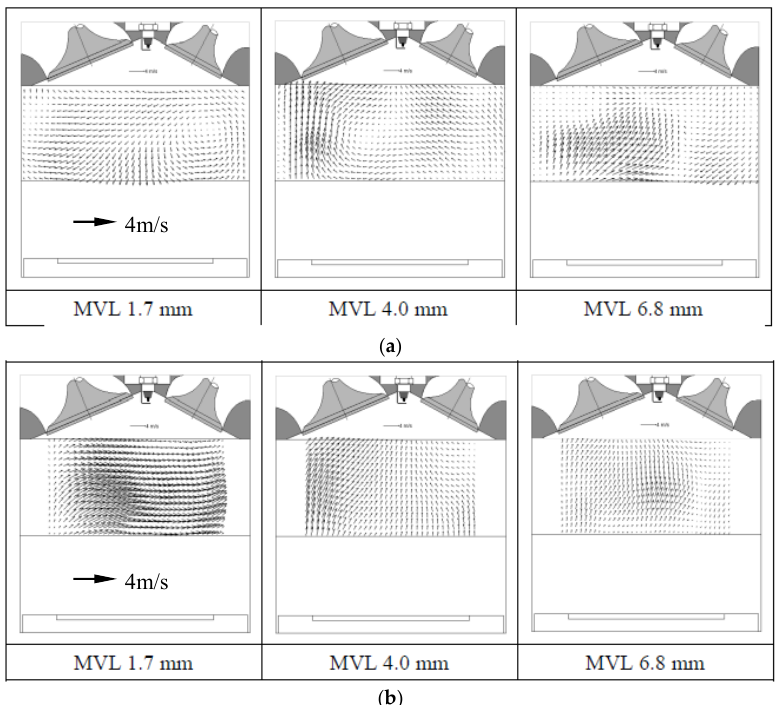
Figure 11. Tumble flow ensemble ‐ averaged flow fields at 128 °CA (during the intake stroke) for MVL 1.7 mm, 4.0 mm and 6.8 mm: ( a ) at Plane 1 and ( b ) at Plane 2.